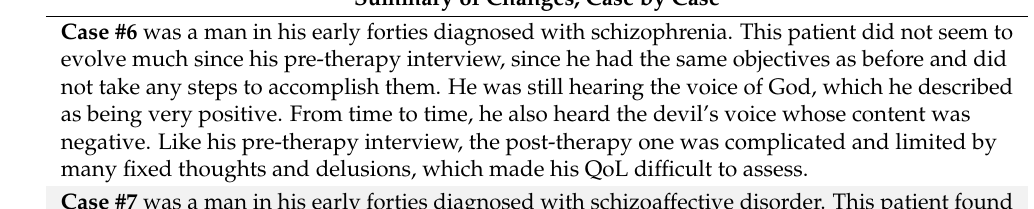
Summary of Changes, Case by